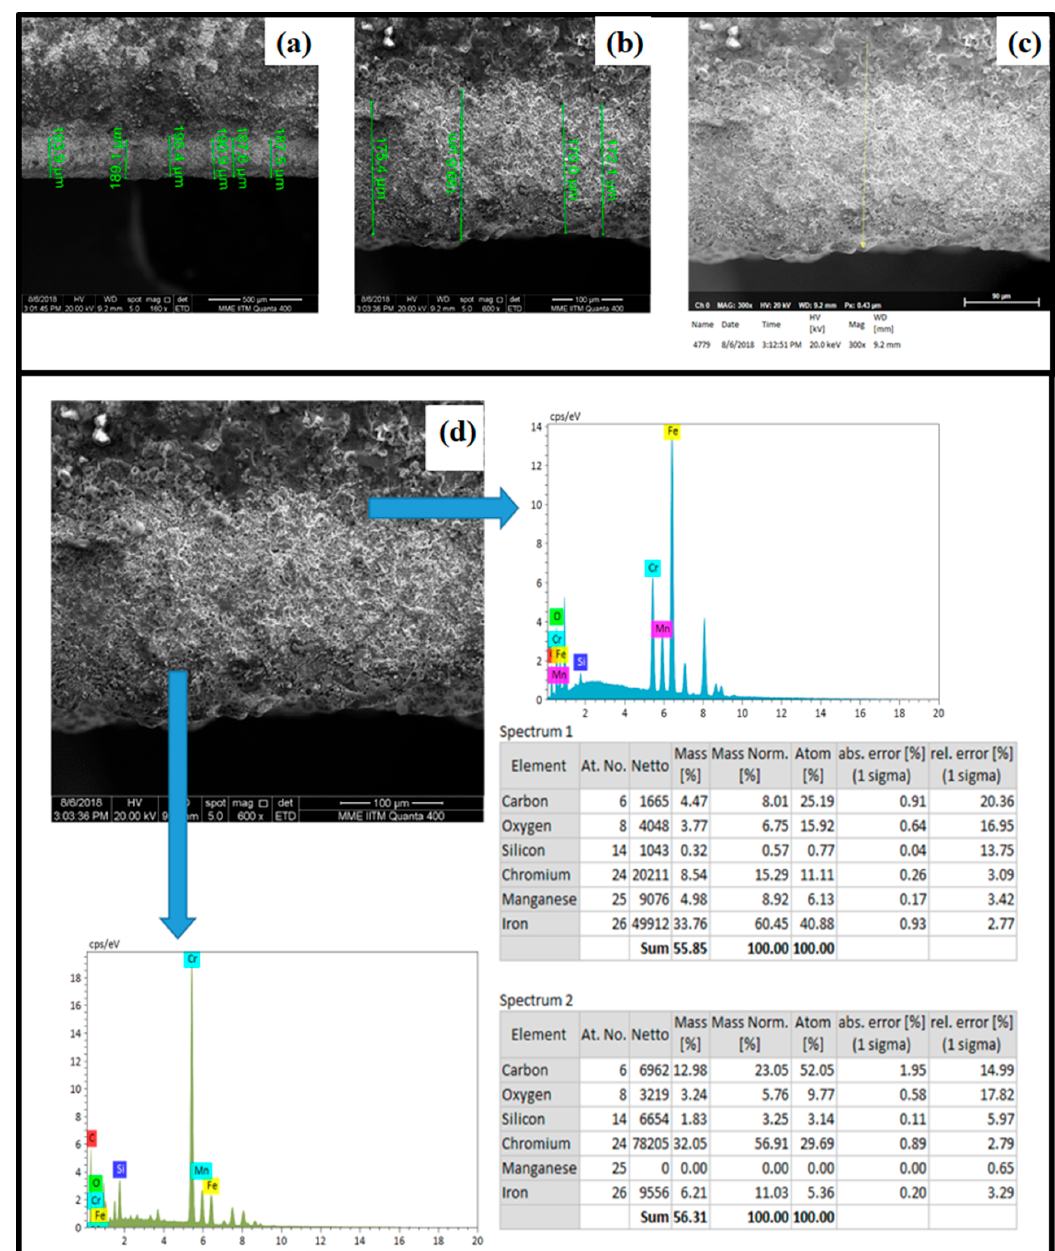
Figure 5. Cross ‐ sectional images of the coating at different magnifications to determine the coating Table ( a ) 100x, ( b ) 600x, ( c ) 300x; and ( d ) cross ‐ sectional image with EDS spectra. Table ( a ) 100 × , ( b ) 600 × , ( c ) 300 × ; and ( d ) cross-sectional image with EDS